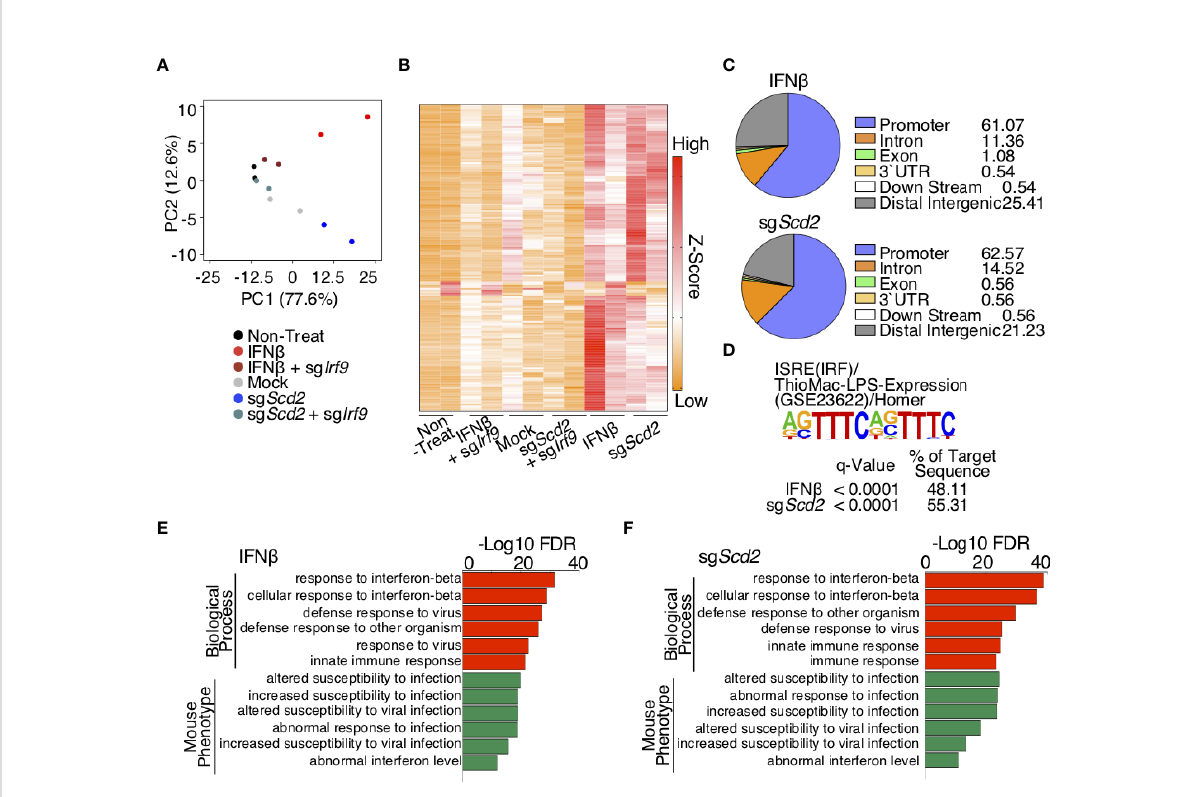
FIGURE 3 IRF9 ChIP-seq analysis revealed similar genome wide binding pro fi le of IRF9 in sgScd2 Th1 cells IFN b -treated Th1 cells. (A) Projections of PC1 and PC2 for normalized IRF9 ChIP-seq signal intensities of derived from non-treat, IFN b , IFN b -treated sgIrf9, mock, sgScd2 and sgScd2/sgIrf9 Th1 cells. Duplicates of each group are shown (ChIP-seq: PC1 77.6%, PC2 12.6%). (B) A heat map depicts the normalized IRF9 ChIP-seq signal intensities relevant to (A) . (C) Pie chart showed the distribution and genomic location of transcription factor IRF9, showing the percentage for each genomic location category in IFN b -treated and sgScd2 Th1 cells. (D) Results of the known motif enrichment analysis de novo motif analysis from IFN b -treated and sgScd2 Th1 cells. (E, F) GREAT analysis of IRF9 ChIP-seq peaks in IFN b -treated (E) and sgScd2 (F) Th1 cells. The enriched terms for GO Biological Process and mouse phenotype are